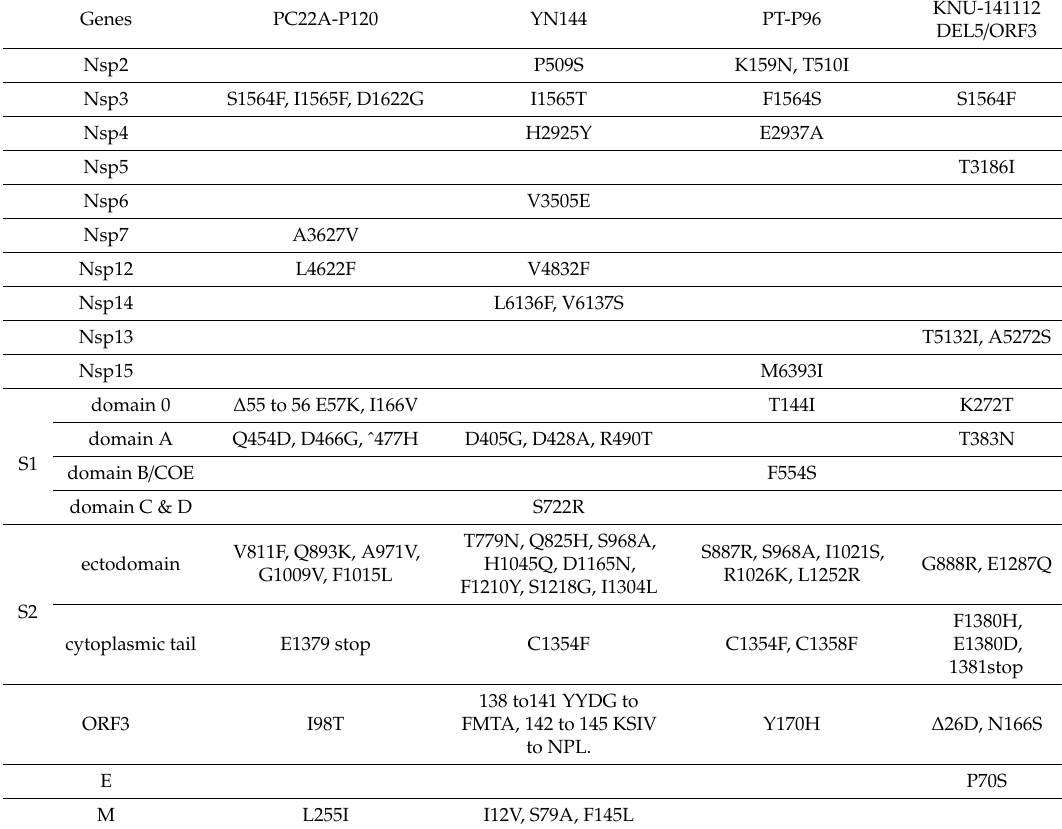
Table 1. Changes of amino acids among four Vero cell-attenuated PEDV G2